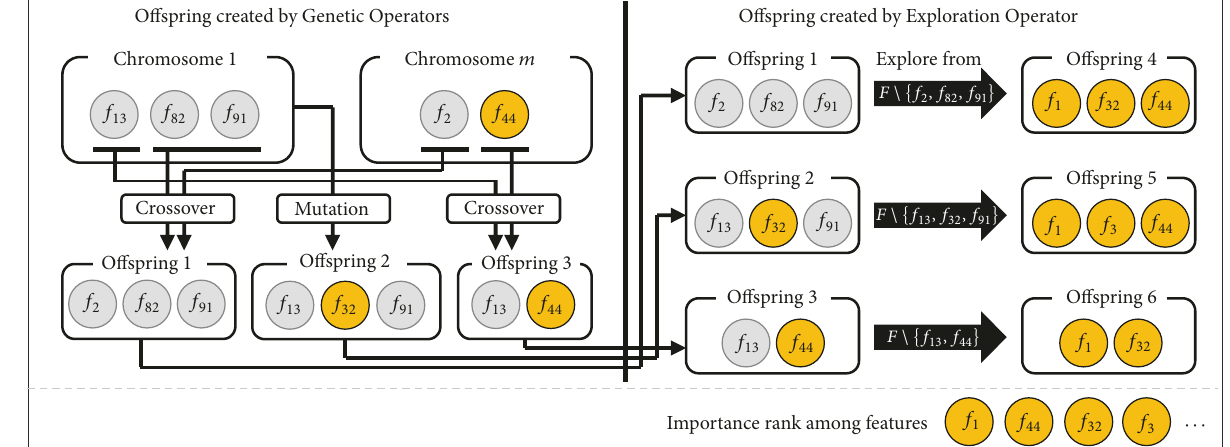
Figure 1: The cooperation process between genetic and exploration